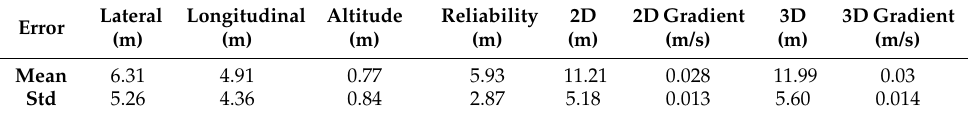
Figure 9. Experiment 2: positioning error and reliability estimation result. The top panel represents the positioning error in lateral, longitudinal and altitude directions, respectively. The bottom panel represents the estimated reliability and 3D positioning error of SLAM. Table 3. Experiment 2: Performance of NDT-based graph SLAM in a sparse area with dense traffic condition. 368